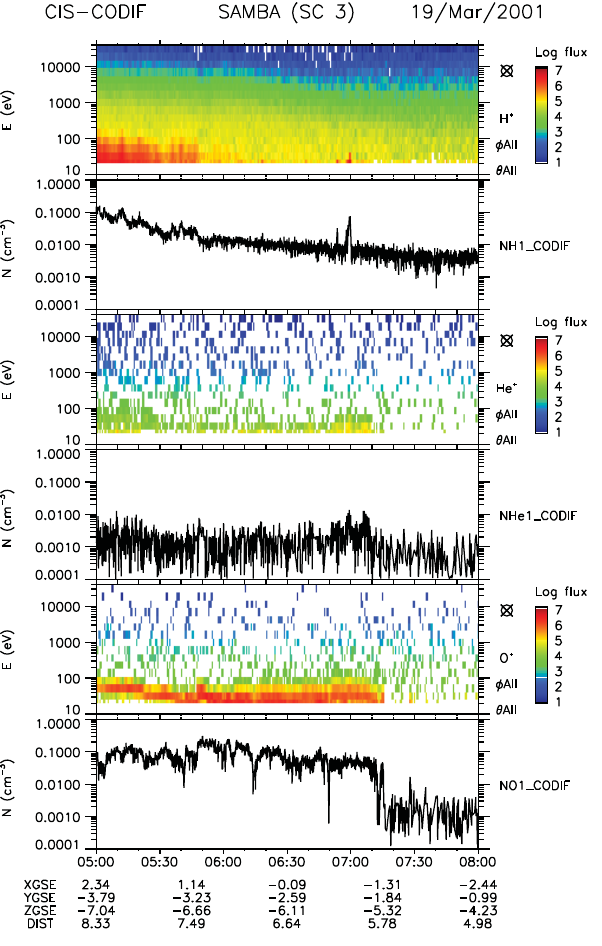
Figure 1c. Three examples of low-energy ions flowing out of the ionosphere during periods without substorms for different levels of geomagnetic disturbances that included quiet arcs and pseudo- breakup auroras. Panels 1, 3 and 5 show the differential number flux spectrograms of H + , He + and O + and panels 2, 4 and 6 show densities of these ions. The data shown come from SC3 but the ions were also observed by SC1 and